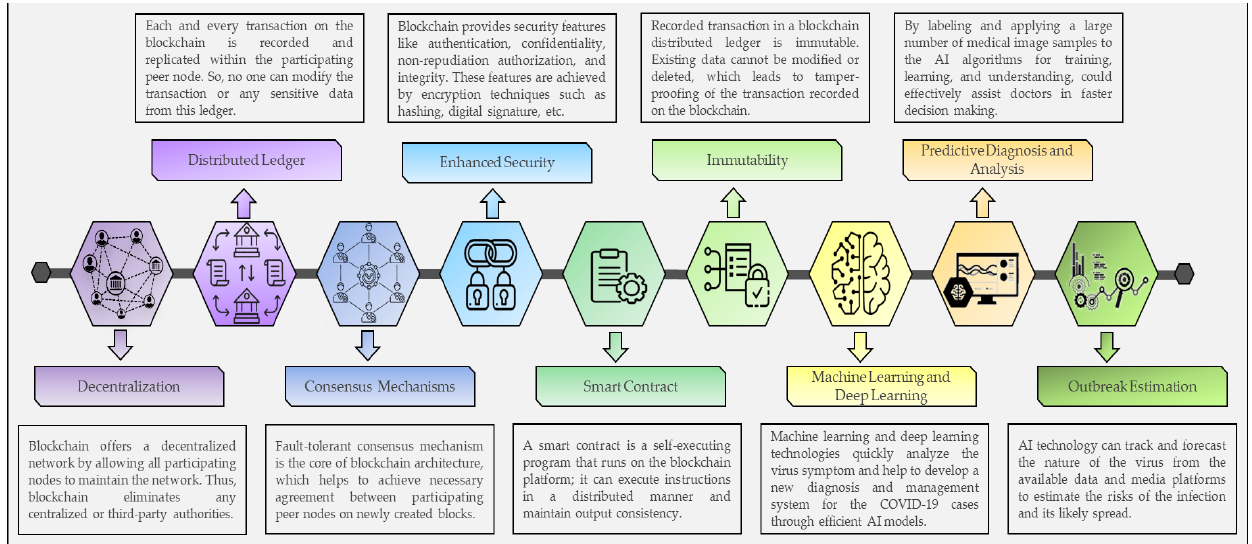
Figure 2. Key features to mitigate COVID-19 challenges using blockchain and AI.